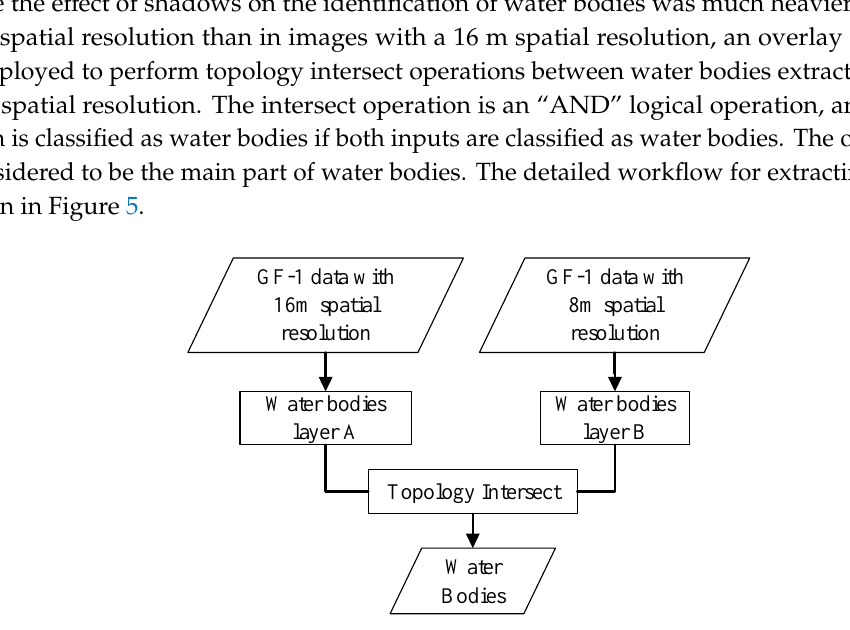
Figure 5. Flowchart for extracting water bodies.